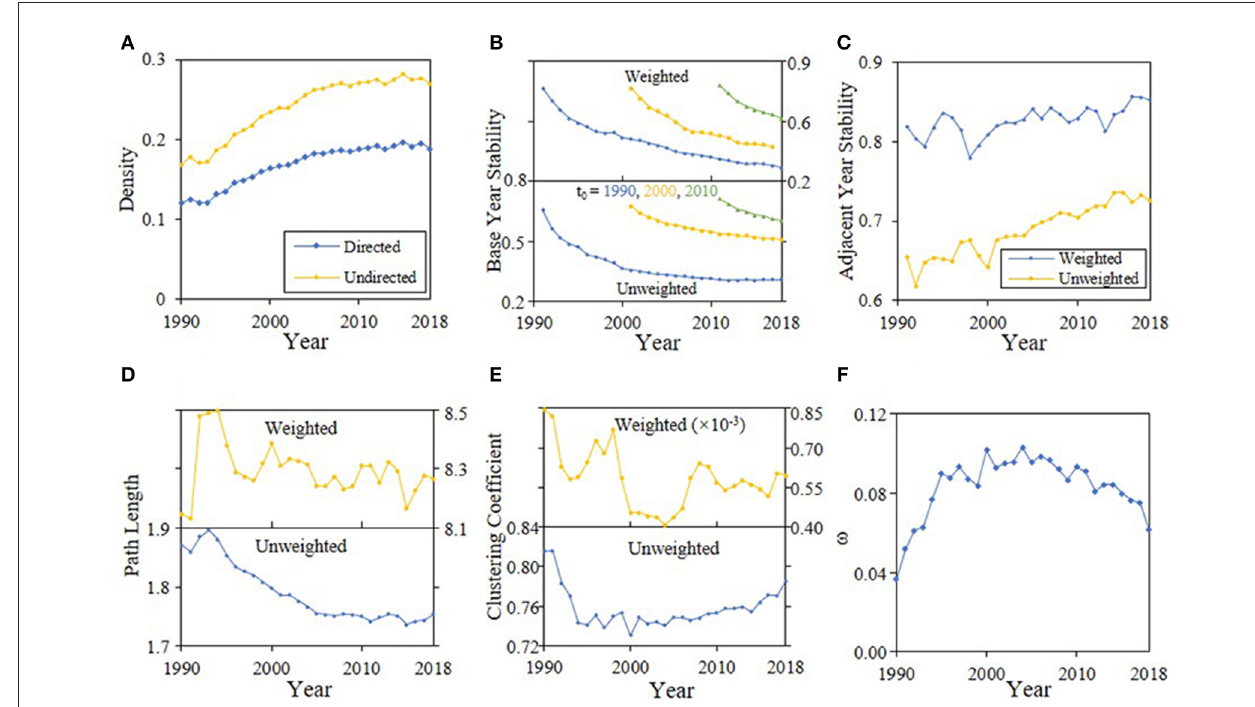
FIGURE4 Network structure dynamics of ITN-Fish in 1990–2018. (A) Directed and undirected network densities. Weighted and unweighted (B) base period stability (base year t 0 = 1990, 2000, 2010), (C) adjacent stability, (D) shortest path length, (E) clustering coefficient, and (F) small-world index.